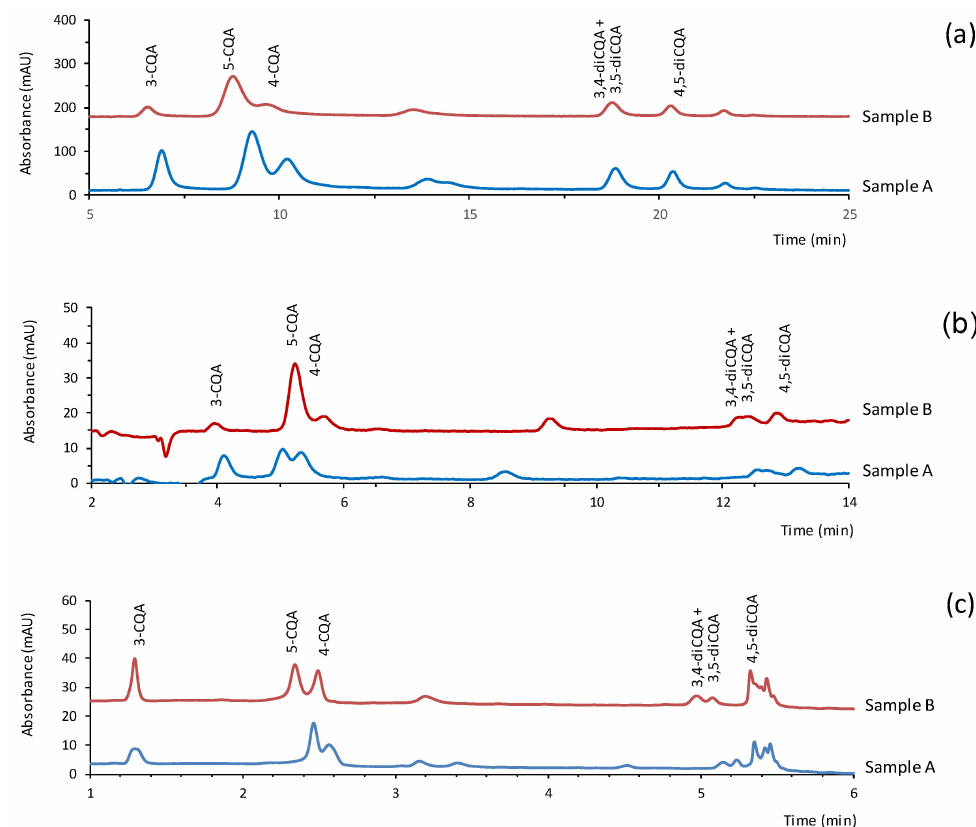
Figure 3. Chromatograms obtained for the samples with the three miniaturized LC systems tested: ( a ) chromatograms obtained at 330 nm with the capLC; ( b ) chromatograms obtained at 330 nm with the benchtop nanoLC system; ( c ) chromatograms obtained at 255 nm with the portable LC. The dilution factors for the samples are those listed in Table 3. For other experimental details, see